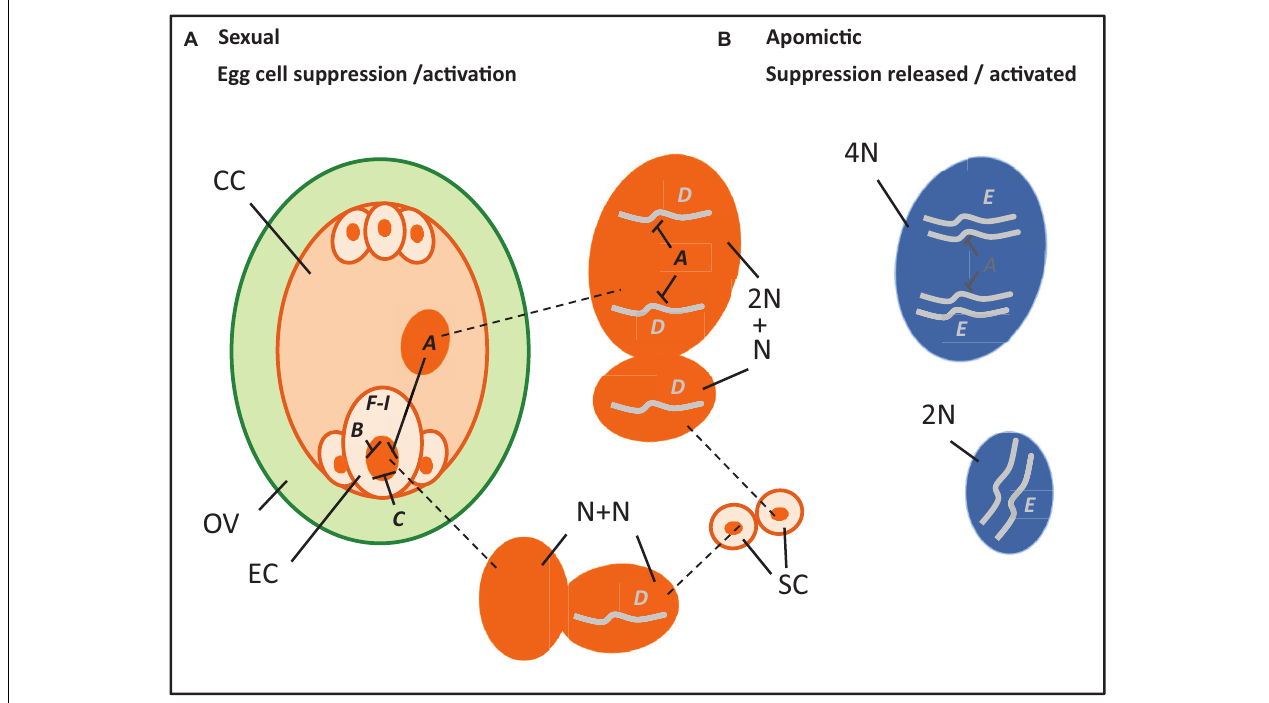
FIGURE 2 | Hypothetical cartoon summarizing the potential processes and genes involved in parthenogenesis ( A–I , with ---| denoting suppression) (see also Table 1 ), with left an ovule (OV, green) that encloses a reduced embryo sac (orange), including an egg cell (EC), central cell (CC), two synergids (next to the EC), and three antipodal cells, and outside it two sperm cells (SC, orange), in the middle the enlarged nuclei (dark orange) of the central cell (top, 2N; N = chromosome set after reduction division), sperm cells (middle, each N) and egg cell (bottom, N) at karyogamy, and right the unreduced nuclei (dark blue) of an apomictic central cell (top, 4N) and egg cell (bottom, 2N). A , B , and C denote genes involved in the suppression of transcription in the egg cell , particularly present in the central cell (A) notably the FIS -PRC2, egg cell (B) possibly RKD -TF, and the surrounding ovular tissue (C) potentially AGO 9. D and E denote genes that support embryogenesis either after fertilization and transferring a paternally expressed, maternally silenced gene (D) as hypothesized for Os-BBM 1, or via natural expression in an apomict (E) as is found for PsASGR-BBML and possibly involves reduced or absence of suppression. F – I denote genes and other stimuli that are found to be involved in embryogenesis either after ectopic overexpression to induce somatic embryogenesis (F) , for example, LEC 2, increase embryogenesis capacity (G) , e.g., SERK 1, being involved in auxin response (H) as recently found for bHLH 49, or changes in physiological conditions and abiotic stress factors (I) such as Ca 2 + and heat